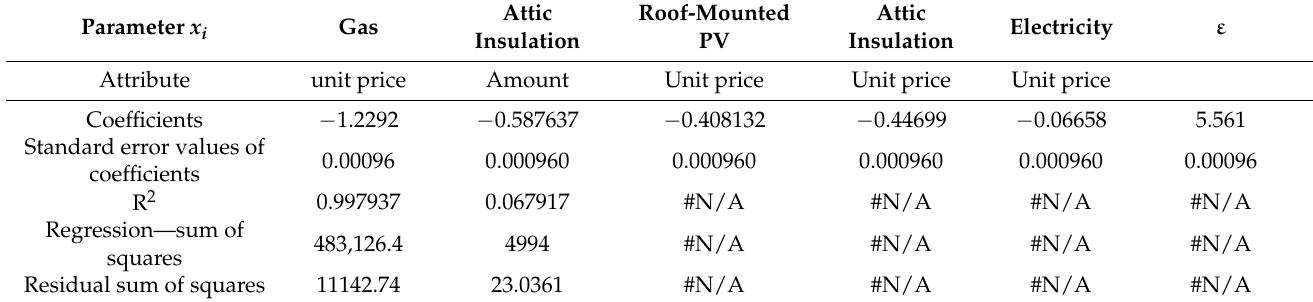
Table A2. Regression parameters for calculation model with gas.